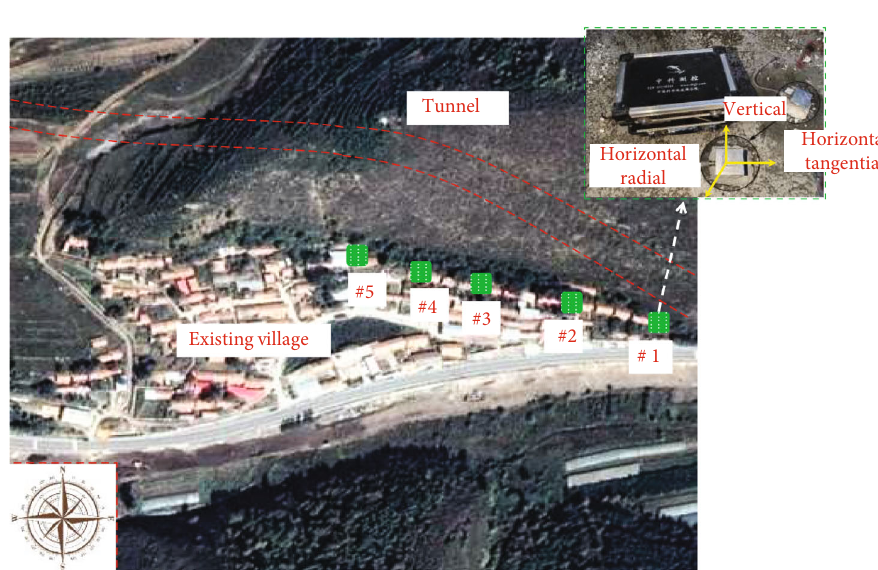
Figure 4: Layout of measuring